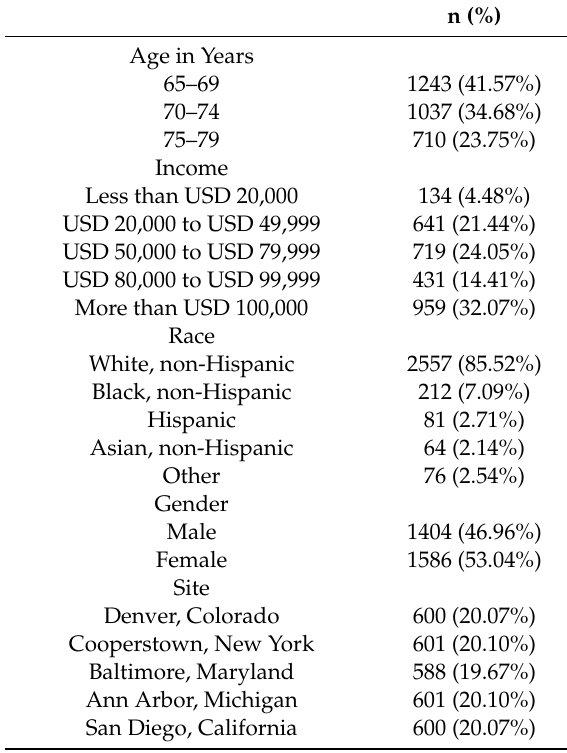
Table 1. Demographic Characteristics of the Study Participants (n =